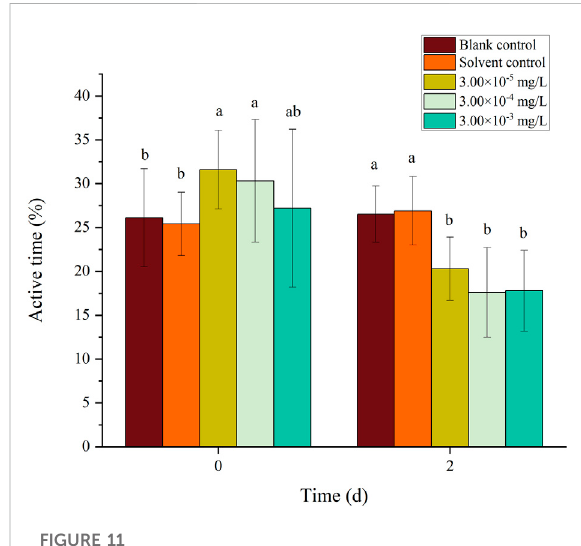
FIGURE 11 Effects of the mixture systems of fenvalerate and tebuconazole on the active time of zebra fi sh larvae locomotion.